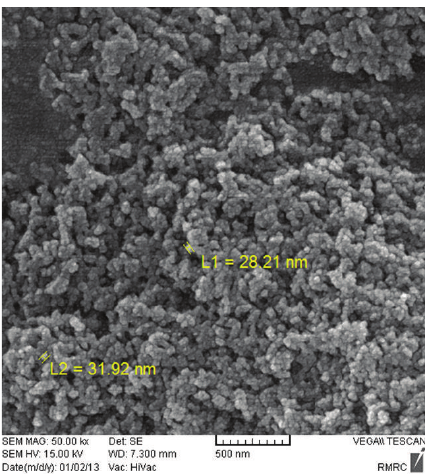
Figure 1: The SEM images of SiO 2 -OSO 3 H NPs.